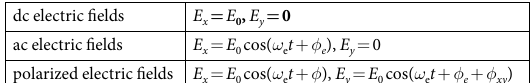
Table 1. Three forms of external electric fields. For ac electric fields, φ e is the initial phase. For polarized electric fields, φ e is the initial phase of E x , φ e + φ xy the initial phase of E y , and φ xy the phase difference. The mode of the polarized electric field is characterized by φ xy . For examples, the polarized electric field is circularly polarized and rotates clockwise for φ xy = 0.5 π , or anticlockwise for φ xy = 1.5 π . See ref. 47 for more details. A small electric strength E 0 = 0.005 is chosen throughout this